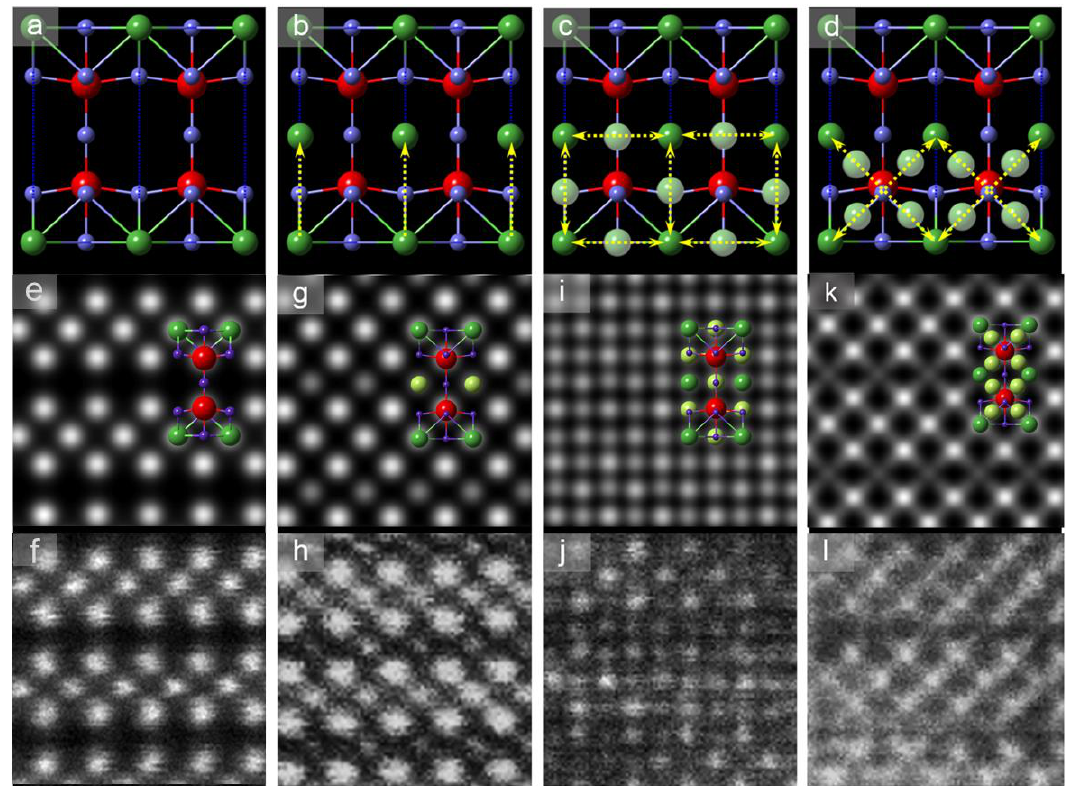
Figure 5. ( a , b ) Structure models of the ground state and metastable states. Note that the green La atoms have a probability of 1/3 to be a vacancy even in the pristine electrolyte. La A1 → La A2 migration leads to the metastable state in ( b ), where yellow arrows mark the kinetic pathways. Consistent with the previous models, red balls stand for Nb, green for La/Li and purple for O. ( c , d ) Nearest-neighbouring and second-nearest-neighbouring La-site migration, together with interstitially trapped La (light green within the yellow arrows). ( e , f ) Simulated and experimental HAADF images of ground-state pristine lattice. ( g , h ) Simulated and experimental HAADF images of metastable defects in ( b ). ( i – l ) Simulated and experimental HAADF images of diverse defects corresponding to different La migration pathways. Structure models are overlaid on the simulated images in ( e,g,i,k ), which are consistent with the experimental images.